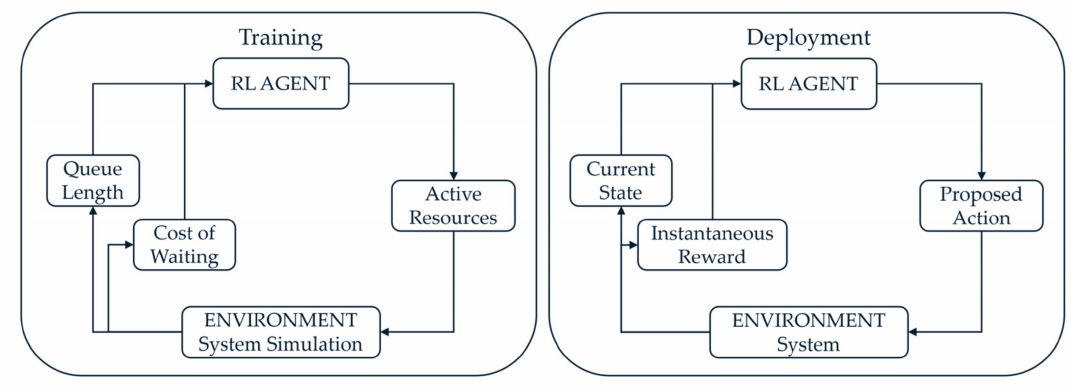
Figure 11. Illustrating RL framework for real-time queue monitoring and resource